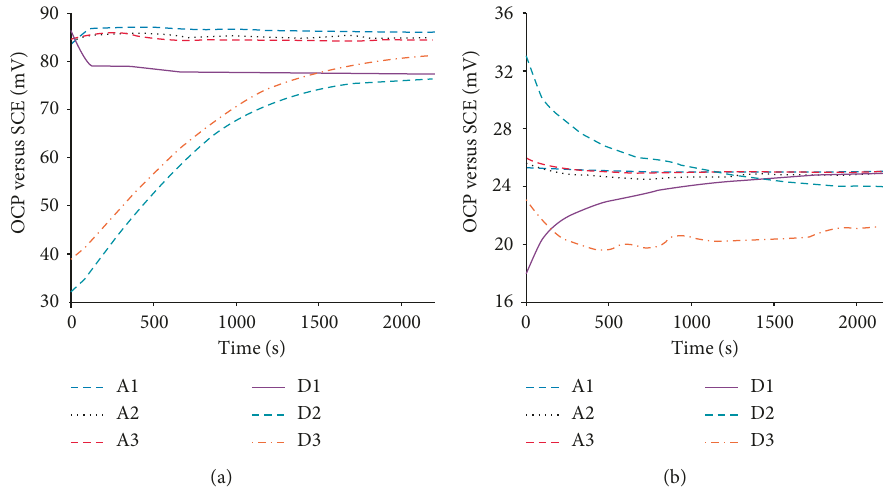
Figure 4: OCP response of replicates of sensors A and D in chloride-containing cement extract (CE): (a) 20mM chloride content; (b) 260mM chloride